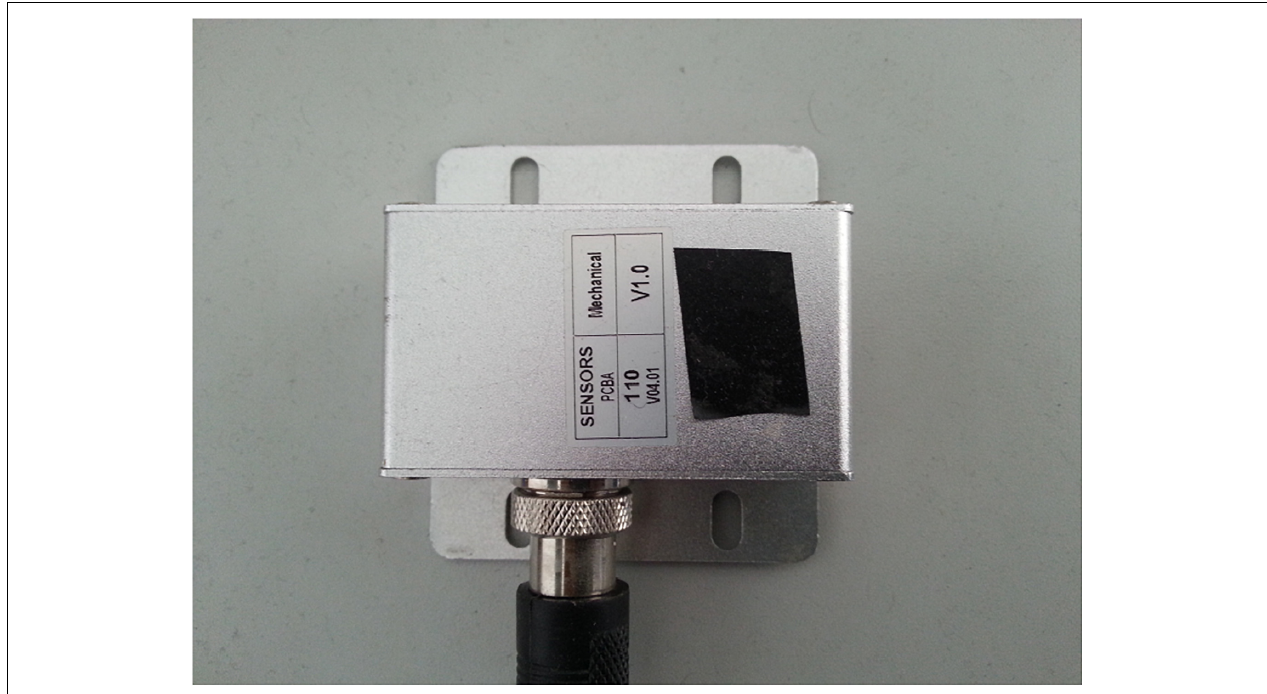
FIGURE 3 | Inertial measurement unit (IMU) on